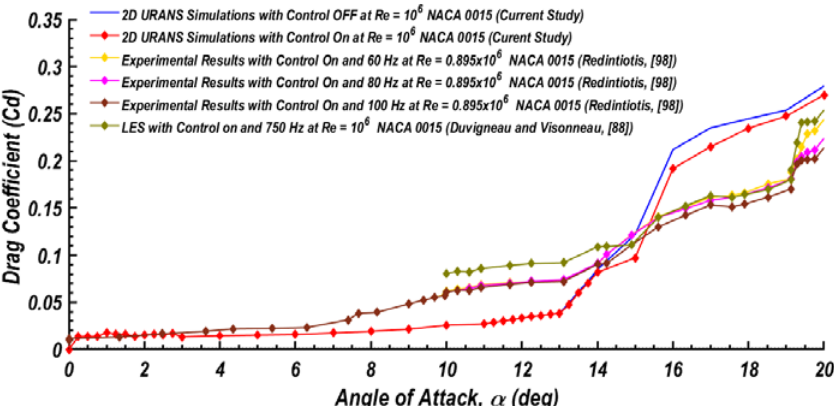
ffi cient as a function of angle of attack at chord Re = 1 Million for control-o ff 28 Figure 28. Airfoil drag coe and control-on cases. Published numerical results and experimental data are also shown for